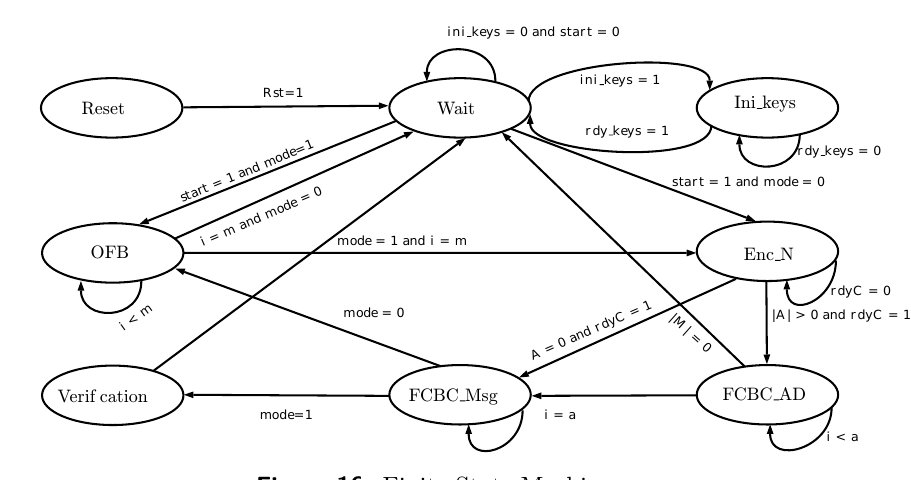
Figure 16: Finite State Machine